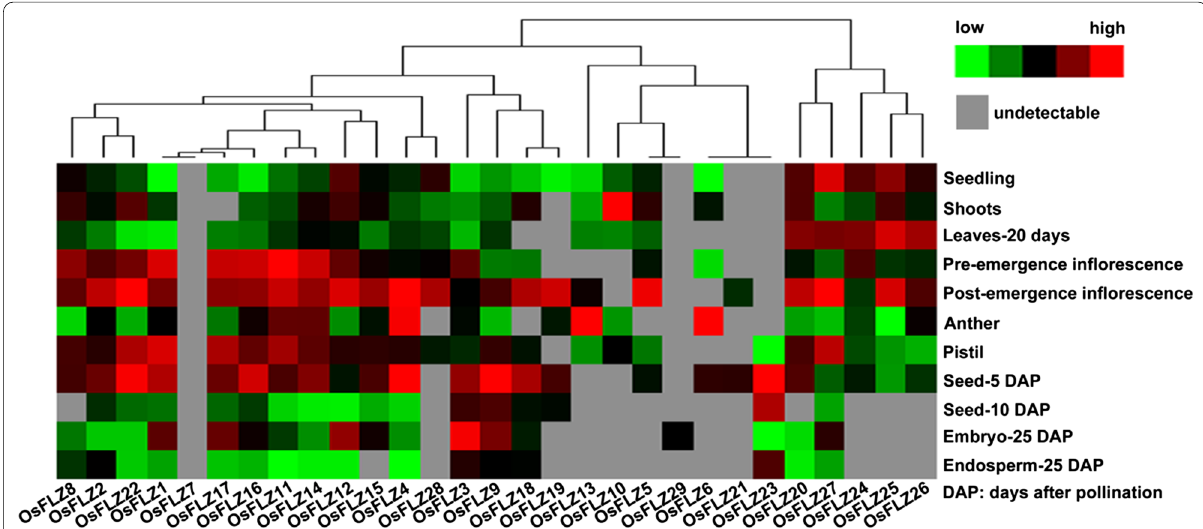
Fig. 2 Heatmap of the gene expression of OsFLZs in 11 different tissues. The color scale represents relative expression level from low (green) to high values (red). The raw data of gene expression were downloaded from Rice Genome Annotation Project (http:// rice. plant biolo gy. msu. edu/)